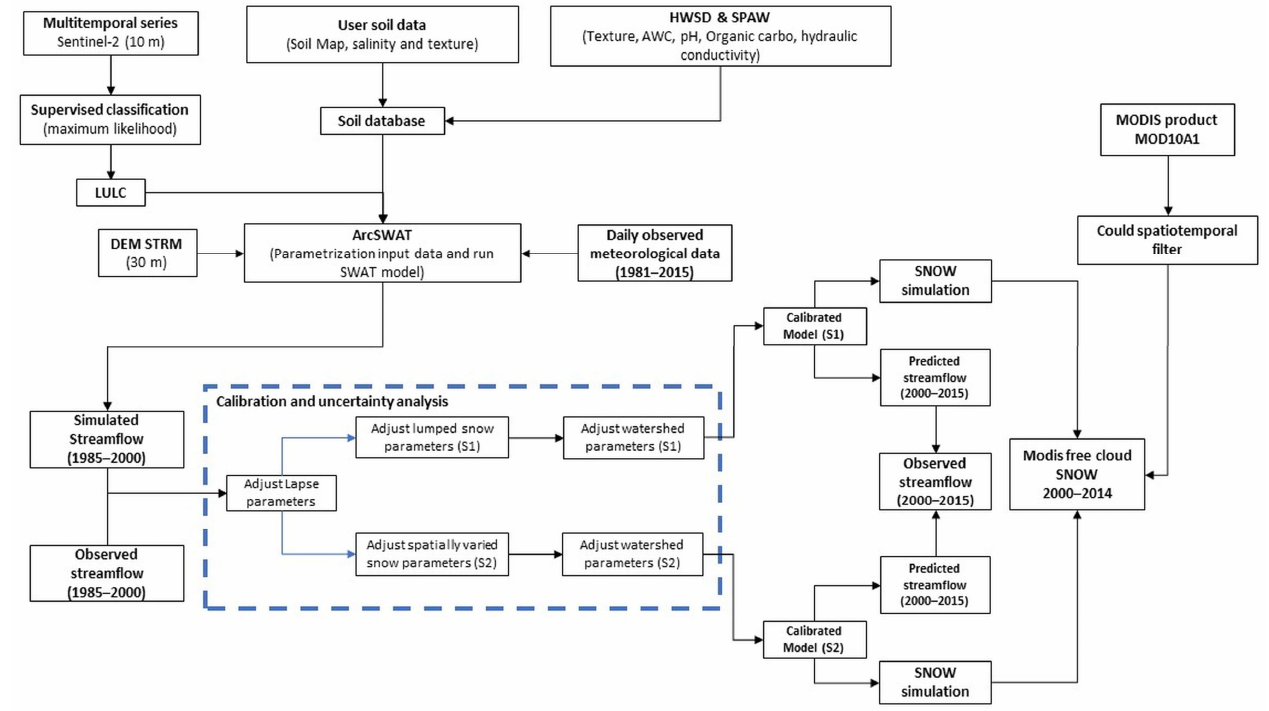
Figure 2. Flowchart of the methodology followed in this